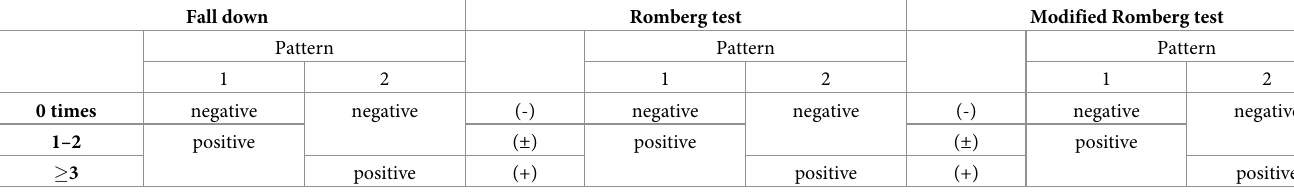
Table 2. Patterns of falls, romberg test, and modified romberg